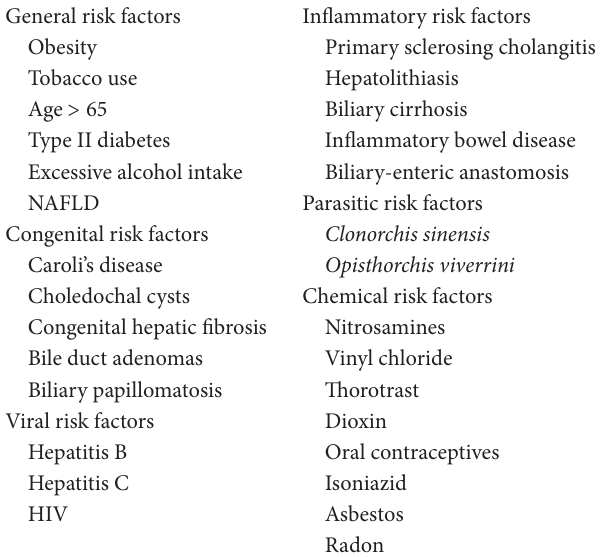
Table 1: Risk factors for